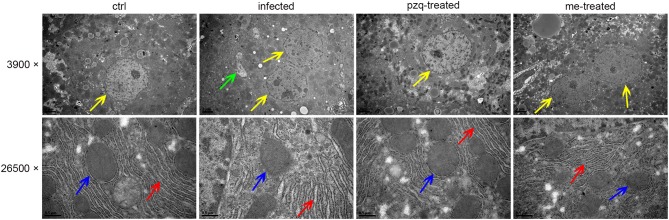
Representative TEM images of pathological changes of liver after treatment of S. japonicum infected mice with praziquantel or myricetin. The yellow, green, red and blue arrows indicate cell nucleus, fiber, endoplasmic reticulum and mitochondria, respectively. Scale bars: upper row, 2 μm; lower row, 0.5 μm. ctrl, the control group; infected: S. japonicum infected group; the pzq-treated, the praziquantel-treated group; me-treated, the myricetin-treated group.